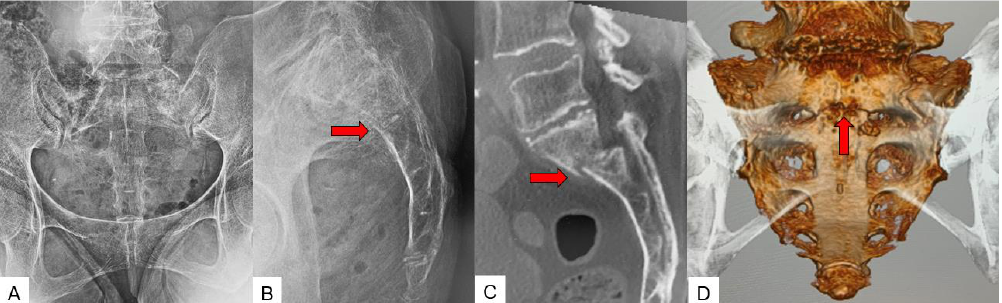
Figure 1. Sacral insufficiency fracture. ( A ): Anteroposterior radiograph, ( B ): Lateral radiograph, ( C ): Sagittal CT, ( D ): 3D CT, red arrows indicate fracture line.